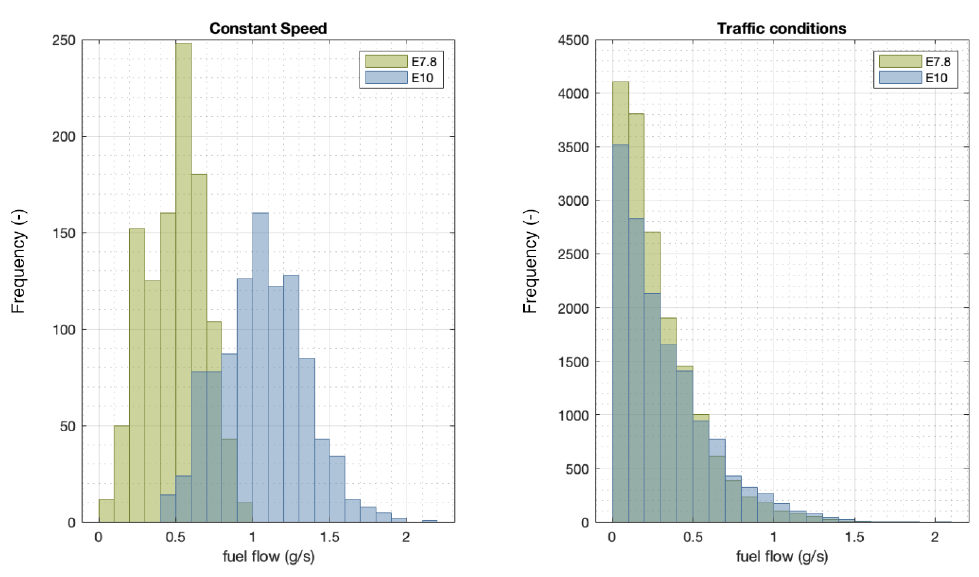
Figure 11. Test regime comparison for fuel flow between fuel blends.